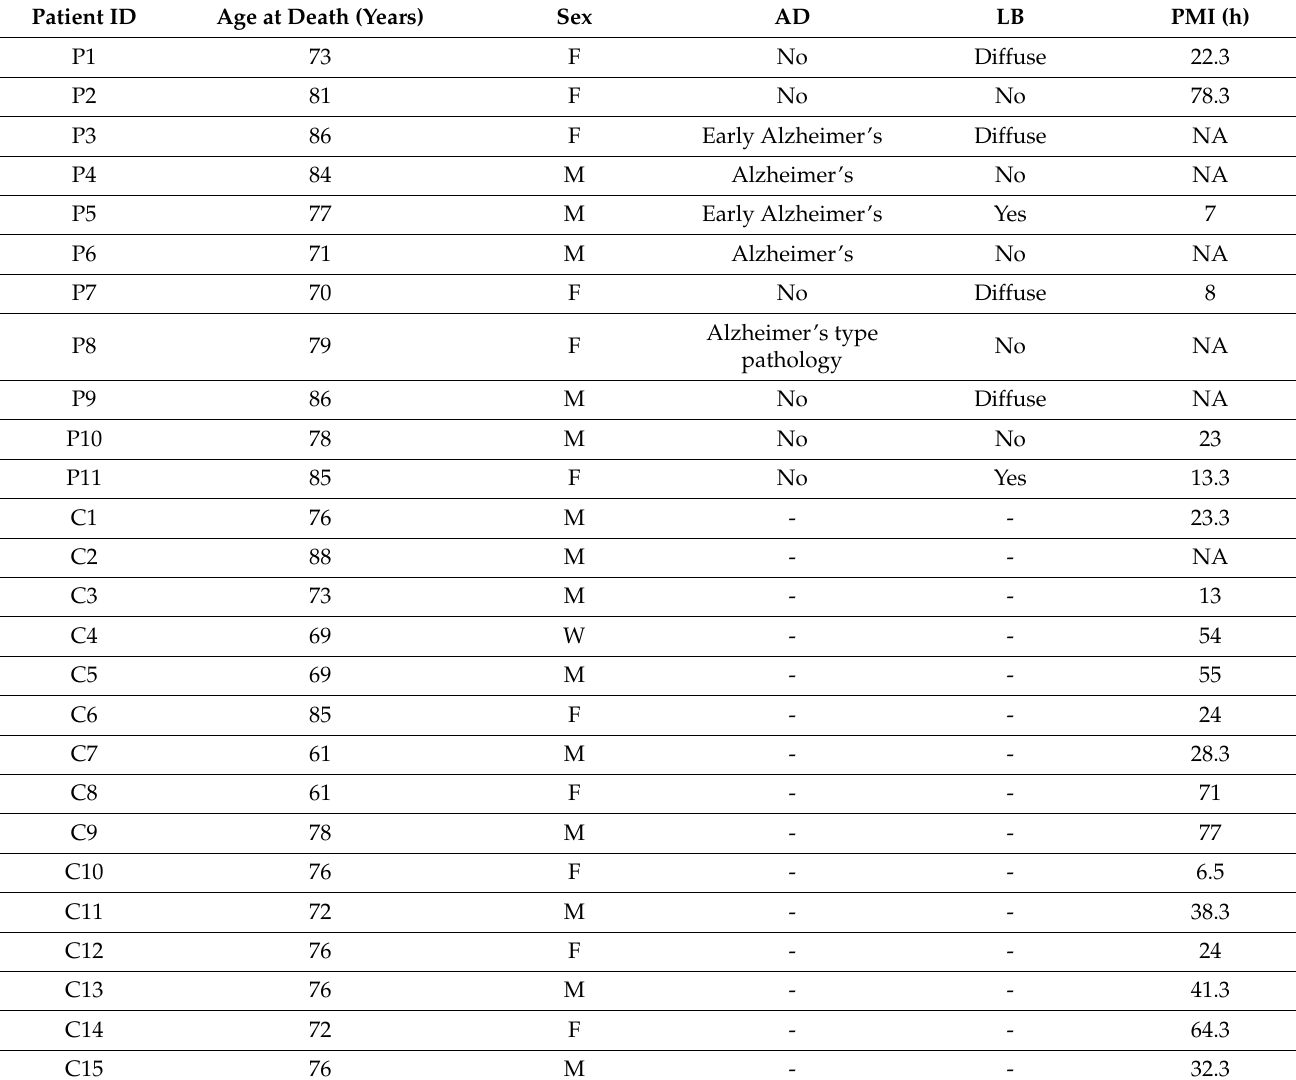
Table 1. Demographic and clinical characteristics of the samples included in the study. In the first column, P1 to P11 indicate the PD patients while C1 to C15 are the healthy control subjects. Age at the death and sex (F = female, M = male) are reported in the second and third columns, respectively. Co-morbidity with Alzheimer’s disease (AD) is reported in the fourth column while the presence of Lewy bodies (LB) is shown in the fifth column. When available, postmortem interval (PMI) is indicated in the last column. NA = not